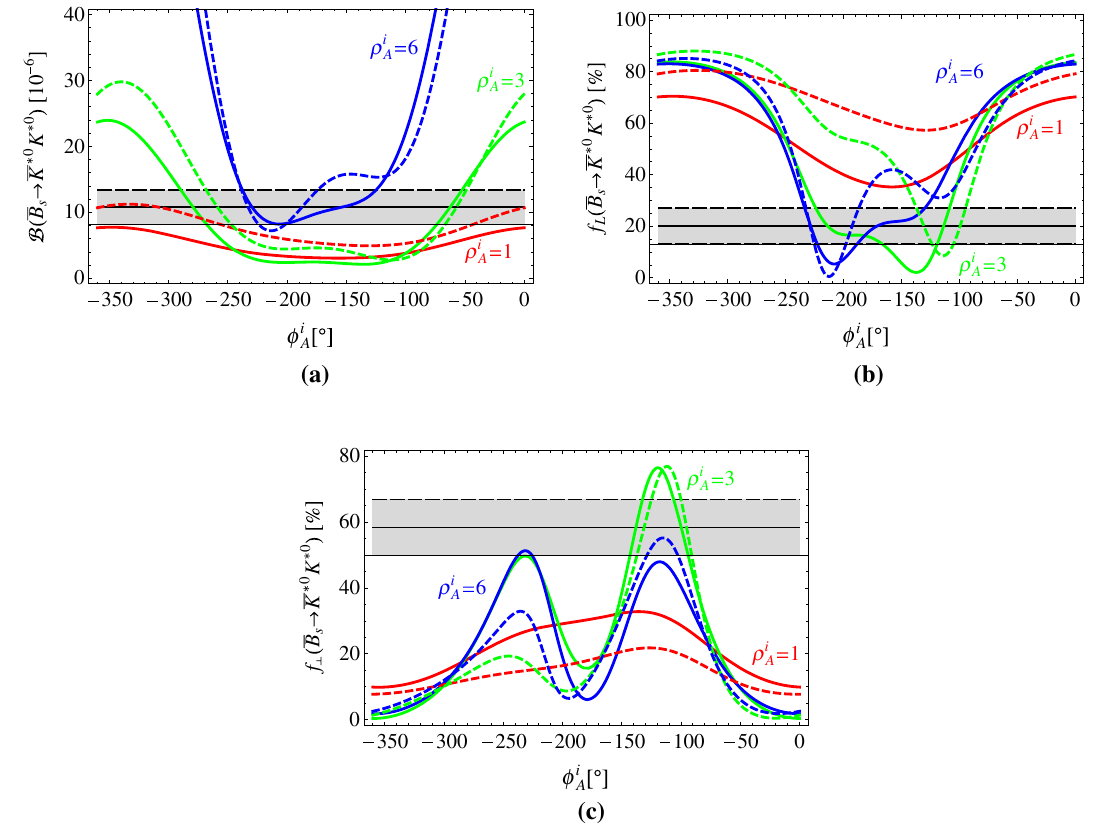
,φ i ) , with fixed (ρ f ,φ f ) = ( 1 . 31 , − 195 ◦ ) ( solid A A A A